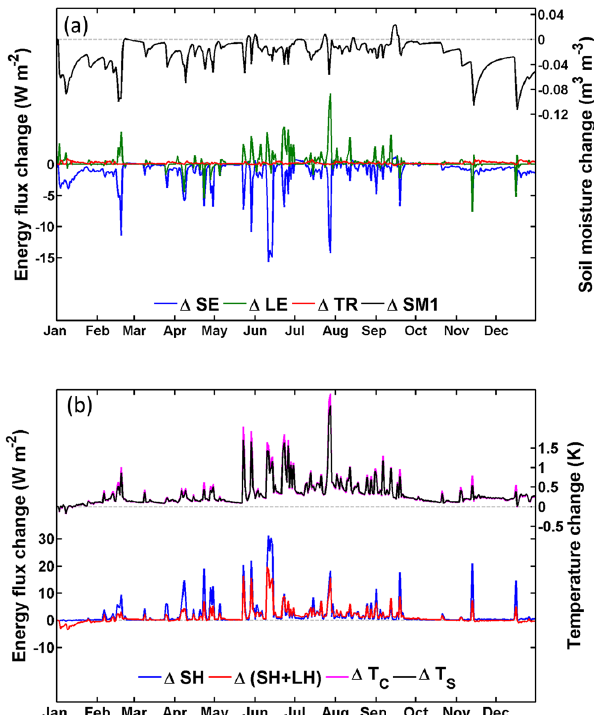
Figure 7. Difference in daily mean heat fluxes and soil moisture due to stem–root flow at the LHC case. (a) Changes in soil evaporation (SE; blue curve), leaf evaporation (LE; green curve), transpiration (TR; red curve) and soil moisture of the surface layer (SM1; black curve; right axis); (b) changes in sensible heat (SH; blue curve), total heat (sensible heat plus latent heat (SH + LH); red curve), canopy air temperature ( T C ; magenta curve; right axis) and soil tem- perature ( T S ; black curve; right axis). Grey dashed lines indicate the zero baseline.